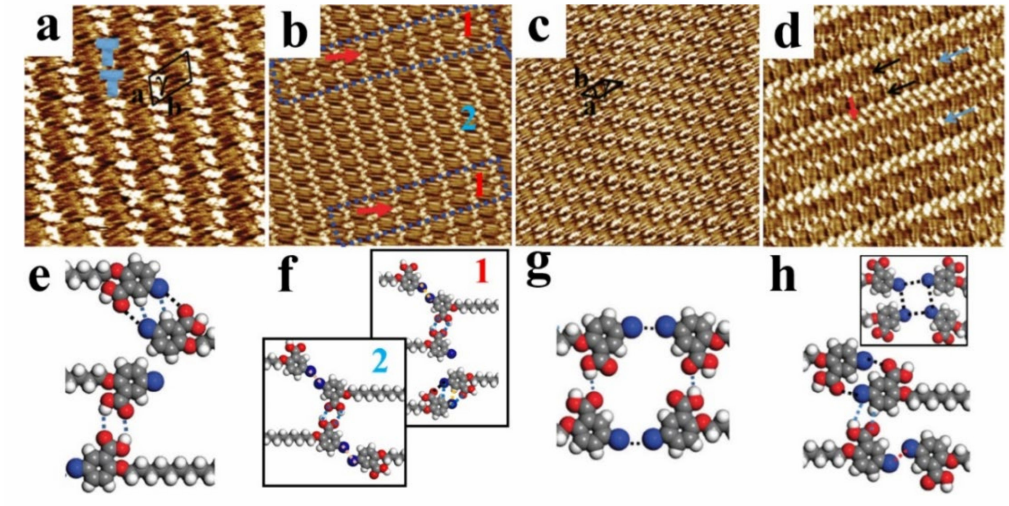
Figure 4. ( a – d ) High-resolution STM images show the self-assembled T-like, dislocated, lip-like, and alternate patterns for the 5-BHBA adlayers at the 1-octanoic acid / highly oriented pyrolytic graphite (HOPG) interface by continually diluting concentration. Scanning areas: ( a ) 20 × 20 nm 2 ; ( b ) 30 × 30 nm 2 ; ( c ) 35 × 35 nm 2 ; ( d ) 42 × 42 nm 2 . ( e – h ) Proposed molecular models for the assembly patterns of ( a – d ). Reproduced from [74] with permission from the Royal Society of